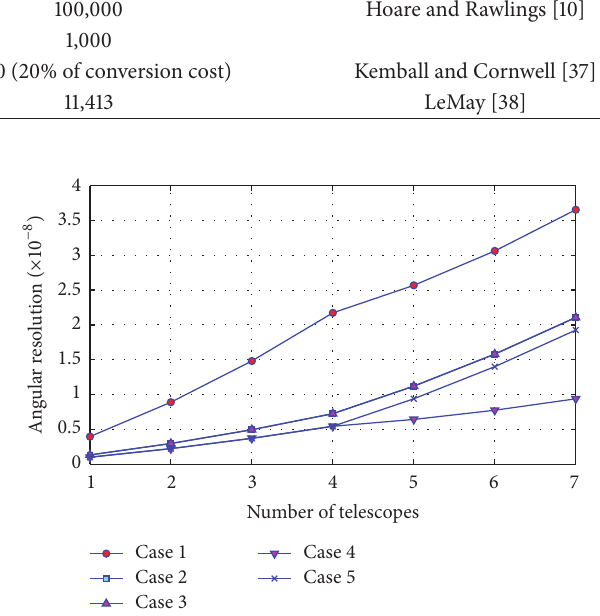
Figure 10: Terrestrial radio astronomy organisation ownership costs.